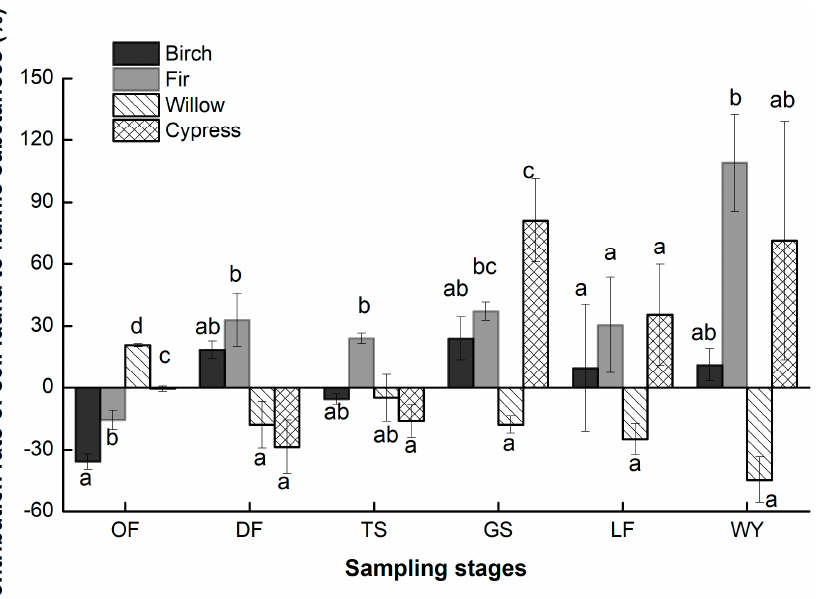
Figure 4. The contribution rate of soil fauna to the accumulation of four litter humic substance in different stages (mean ± standard error, n = 3). OF: onset of freezing stage, DF: deep freezing stage, TS: thawing stage, GS: growing season, LF: leaf falling stage, WY: whole year. The letters a–c mean in the sampling stage with different letters differ significantly, p < 0.05. Table 1. F values for multivariate analysis of variance for individual (D i ) and group density (D g ) of soil fauna, the contribution rate of humic substances (HS), humic acid (HA), fulvic acid (FA), and humification degree (HD) by species and time.